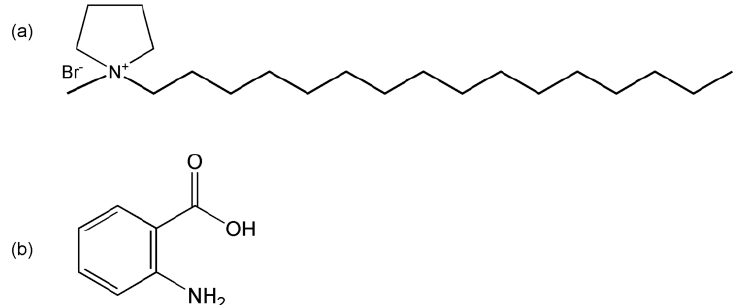
Figure 10. The molecular structure of N -hexadecyl- N -methylpyrrolidinium bromide (C16MPBr) ( a ) and anthranilic acid (AA) ( b ).